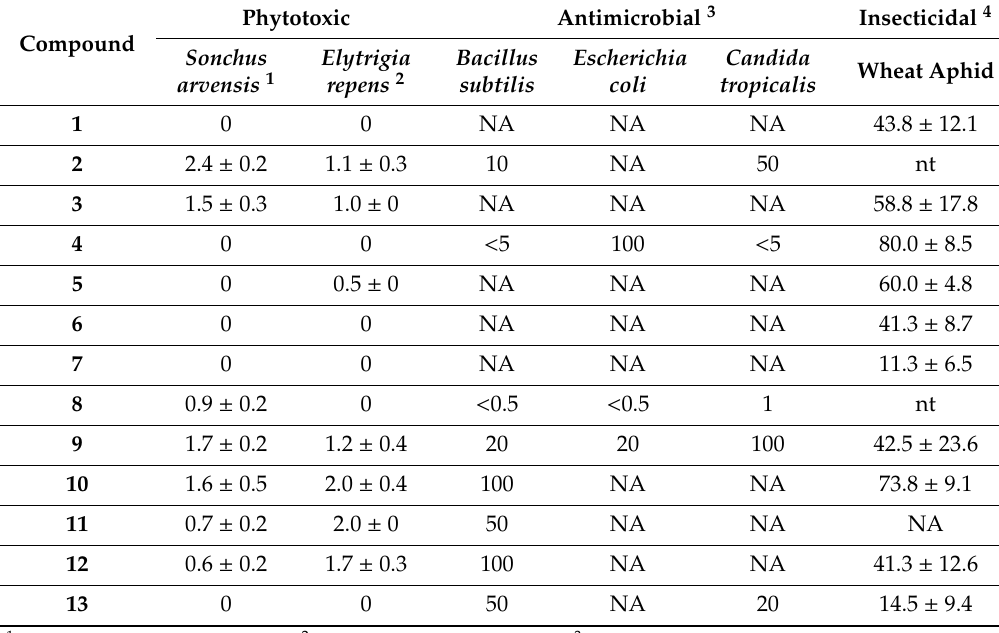
Table 3. Biological activity of isolated compounds 1 – 13 .